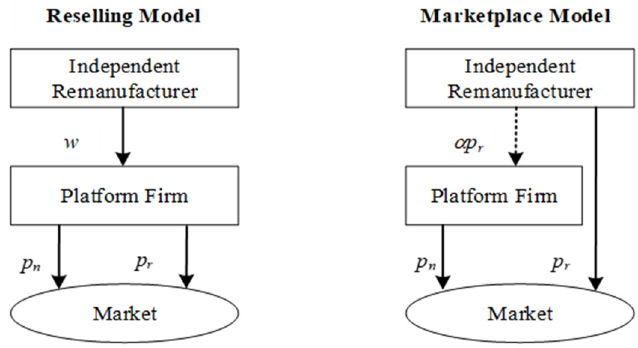
Figure 1. Structure of two marketing models.